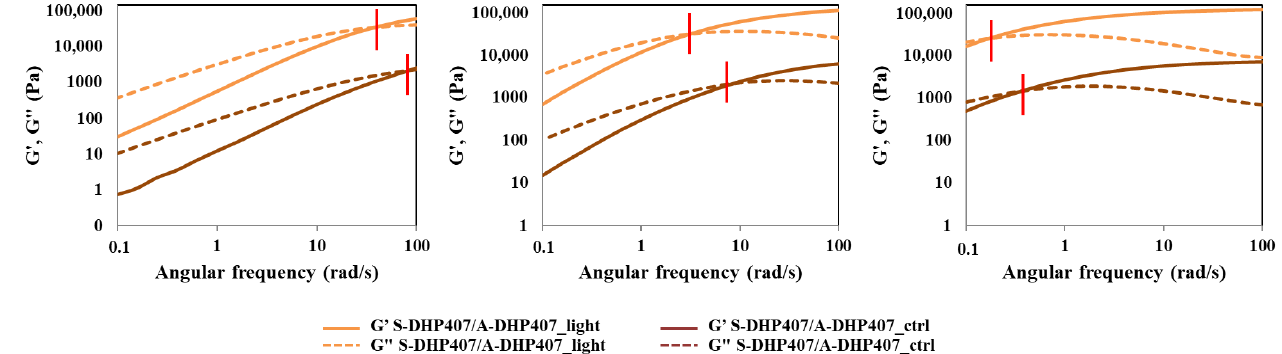
Figure 7. Frequency sweep tests conducted at 25 °C, 30 °C and 37 °C (from left to right) on S- DHP407/A-DHP407 formulations before (dark orange) and after (light orange) exposure to green light (525 nm, 80,000 Lux for 10 min). Continuous and dashed lines represent the storage (G’) and loss (G”) moduli, respectively, while the red bars identify the G’/G’’ crossover frequency. For higher clarity, G’ and G” values of control samples were divided by a factor of 10.